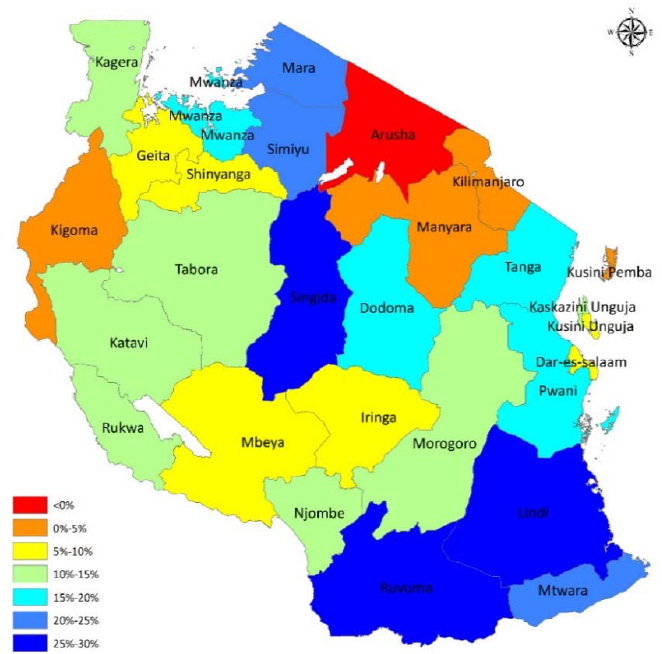
Figure 1. Geographic information system (GIS) mapping of the magnitude change of the burden of child anemia.